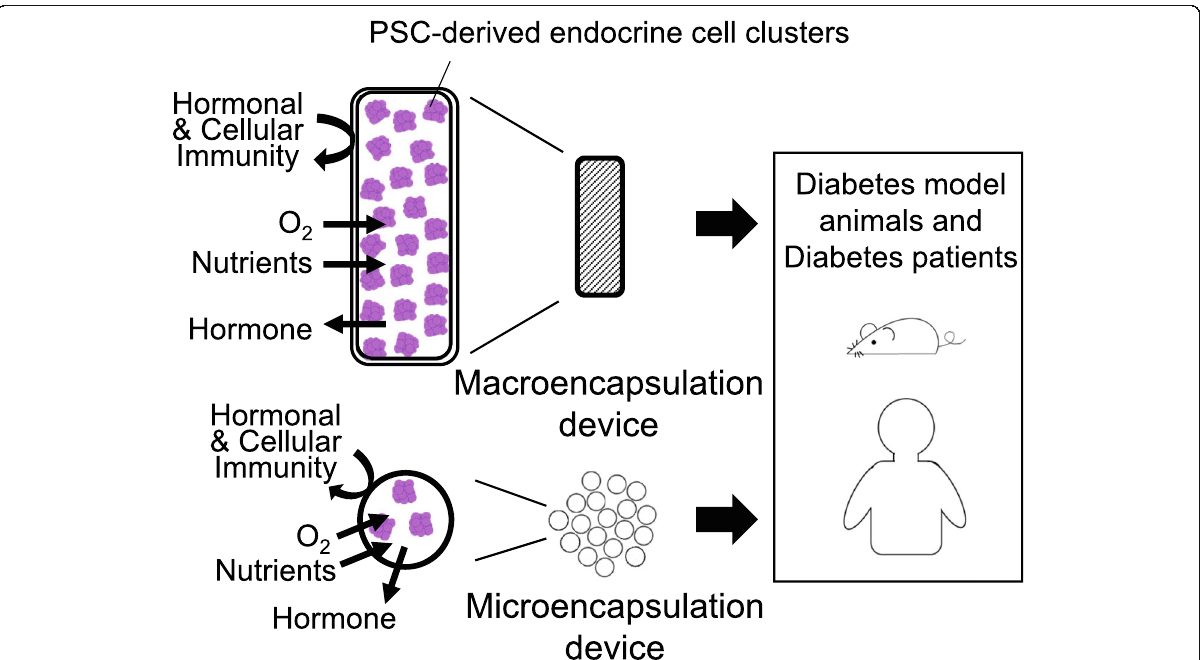
Fig. 2 Macro- and micro-encapsulation devices for the delivery of PSC-derived islet cells. The delivery system of PSC-derived islet cells focusing on macro- and micro-encapsulation devices. Both devices can be loaded with PSC-derived endocrine cell clusters, protect the cells from immune cells, and allow penetration of oxygen, nutrients, and hormone